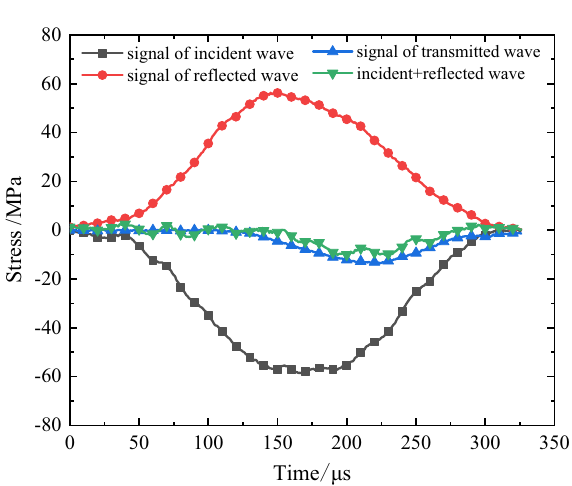
Figure 6. Stress balance diagram of jointed rock sample under SHPB impact